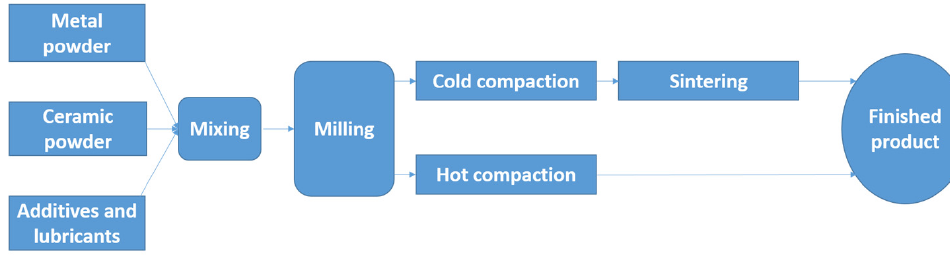
Figure 2. Powder metallurgy process steps for cermets.